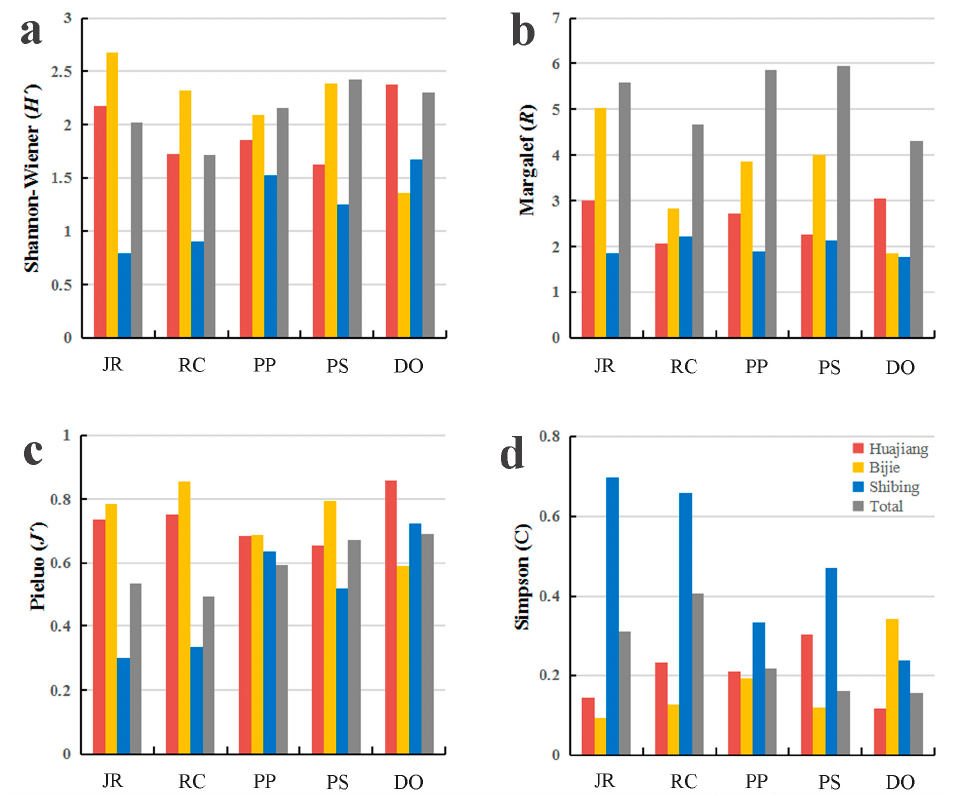
Figure 8. Community diversity of typhlocybine leafhoppers on different host plants (( a ): Shannon–Wiener diversity index ( H’ ); ( b ): Margalef species richness index ( R ); ( c ): Pieluo’s uniformity index ( J’ ); ( d ): Simpson dominance index ( C )).